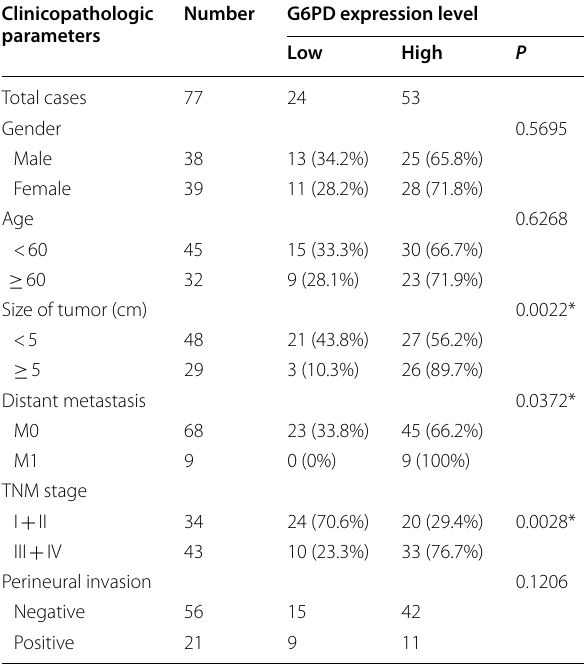
Table 1 Correlation